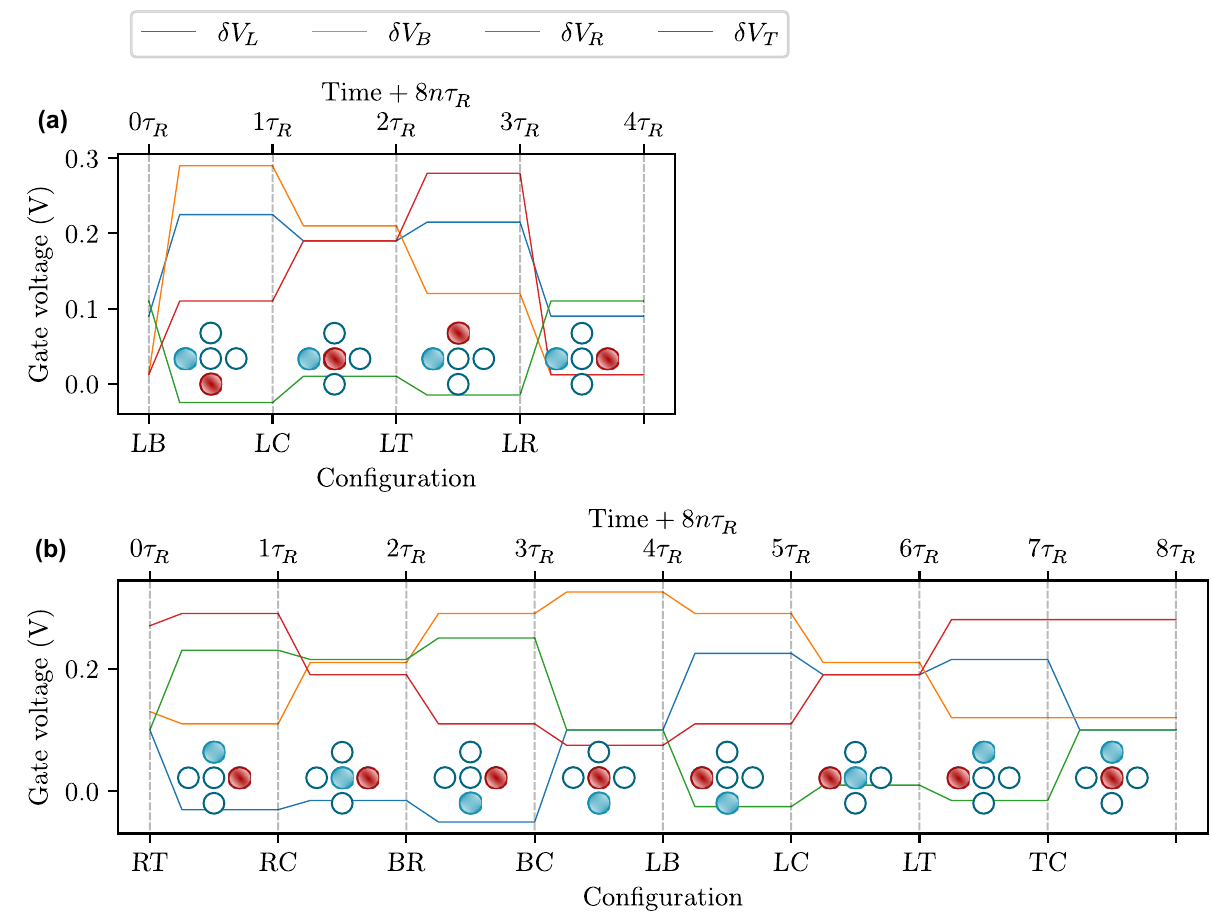
FIG. 6. Periodic electron-displacement sequences. (a),(b) Sequences of nanosecond voltage pulses used to perform the periodic electron displacements. (a) One electron remains in the left quantum dot while the second electron is displaced in the B , C , T , and R dots. (b) One electron periodically visits L , C , and R and the second T , C , and B . The x -axis labels denote the location of the dot occupied by the electron. For example, “LB” denotes one electron in dot L and one in dot B . The schematic representations of the charge configurations are superimposed. Only one period of displacement is shown for each sequence. The voltage rise times are given as